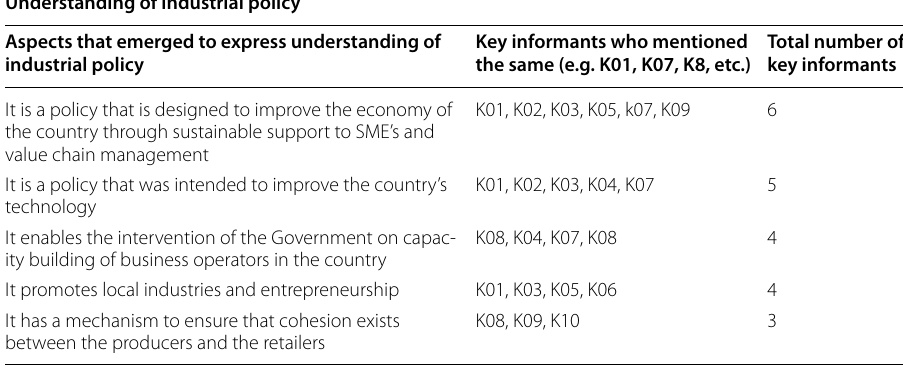
Table 2 Understanding of the industrial policy Understanding of industrial